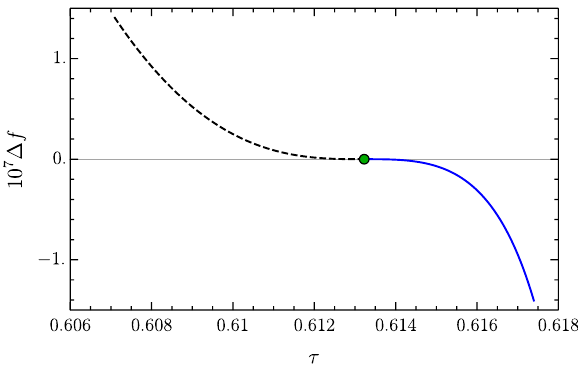
Figure 5 . Phase diagram in the canonical ensemble: dimensionless free energy density di(cid:11)erence (cid:1) f between the triangular (lower blue curve) and hexagonal (upper dashed black curve) nonuniform black membranes and the uniform black membrane for a given dimensionless temperature (cid:28) H . Solutions with the lower free energy are preferred. The green dot locates the zero-mode of the instability of uniform branes, with higher temperatures being